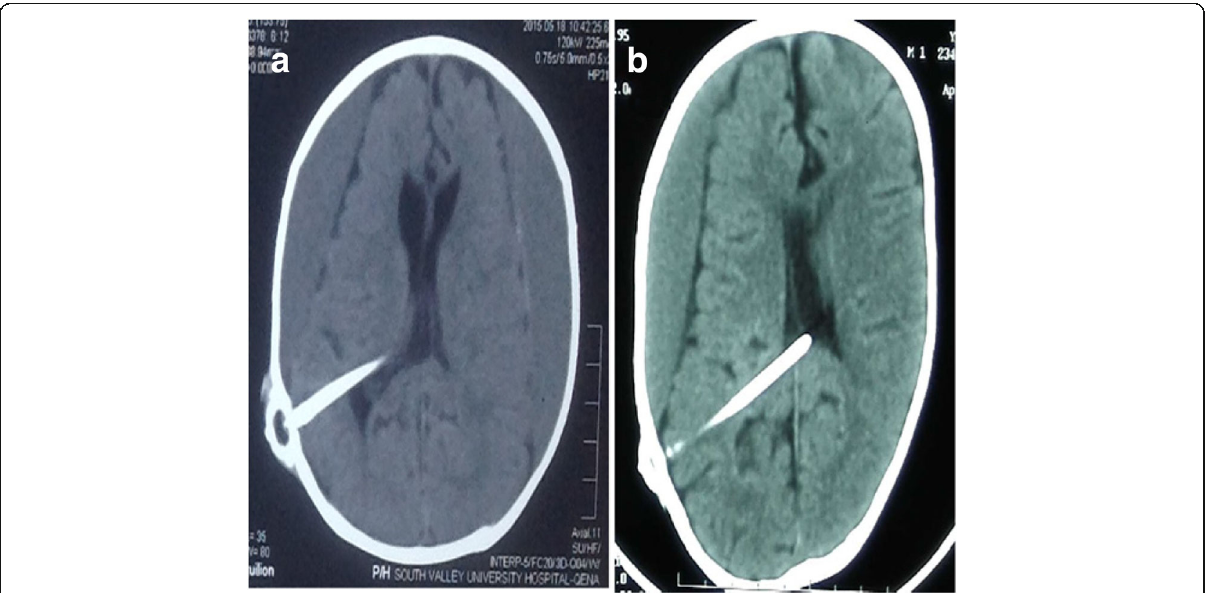
Fig. 5 a Plain CT brain of an 18-month-old infant showing bilateral chronic subdural hematoma due to right-sided VP shunt overdrainage. b Plain CT brain of a 1-year-old infant showing right-sided chronic subdural hematoma due to right-sided VP shunt overdrainage